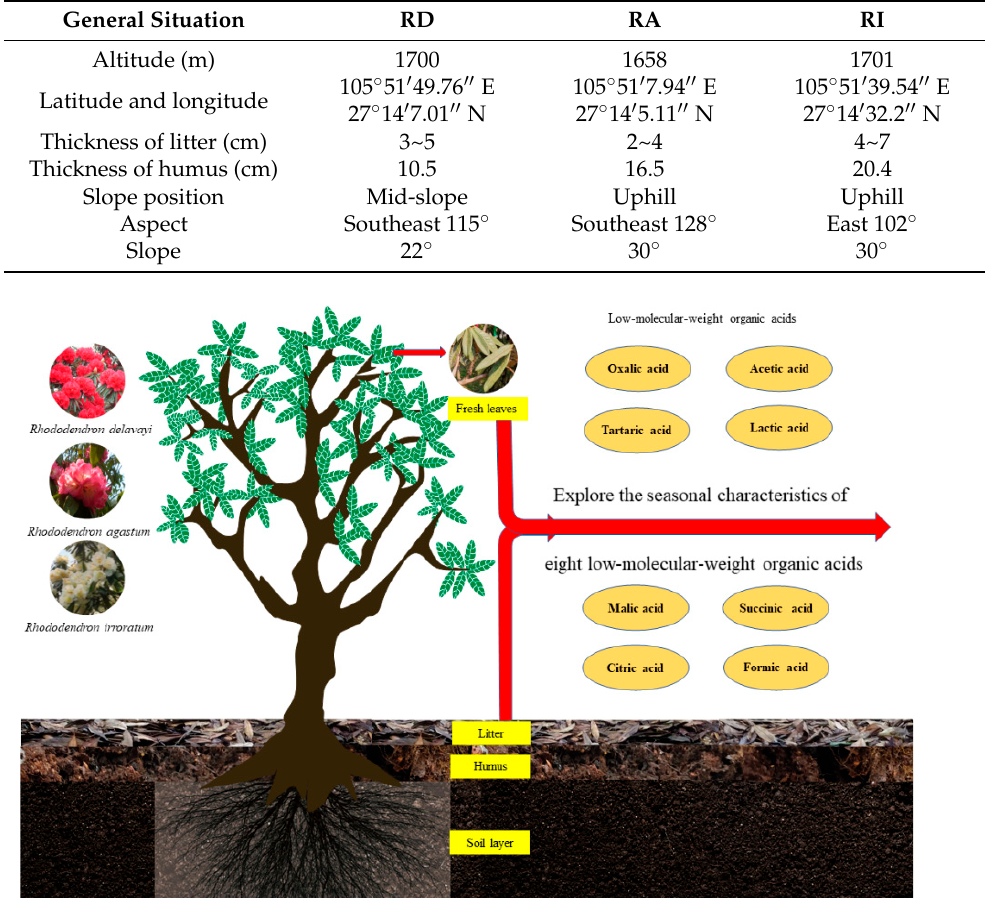
Figure 2. Experimental design showing the research object and research content.